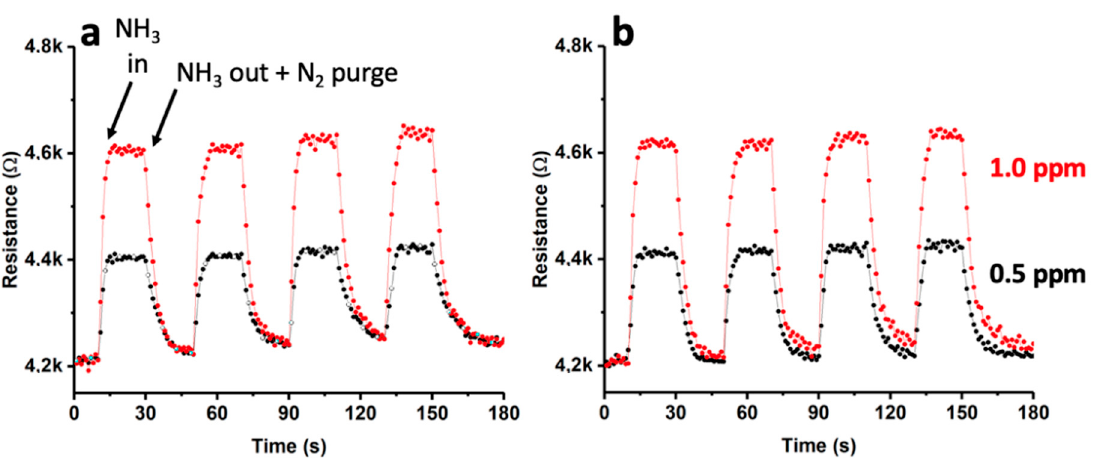
Figure 9. Dynamic response curve for the Au(spu tt ering)-SWCNT composite gas sensor towards NH 3 (0.5 ppm and 1 ppm) at 25 °C ( a ) and 140 °C ( b ). NH 3 (0.5 ppm and 1 ppm) at 25 ◦ C ( a ) and 140 ◦ C ( b